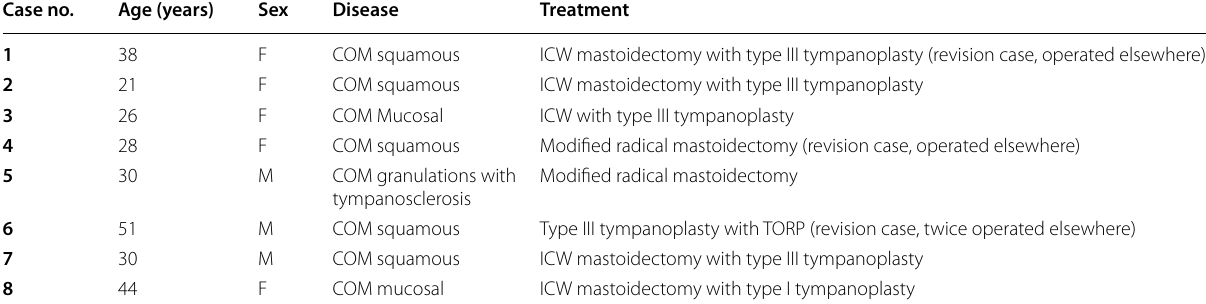
Table 1 Description of patients who had worsening of post-operative hearing status Case no.